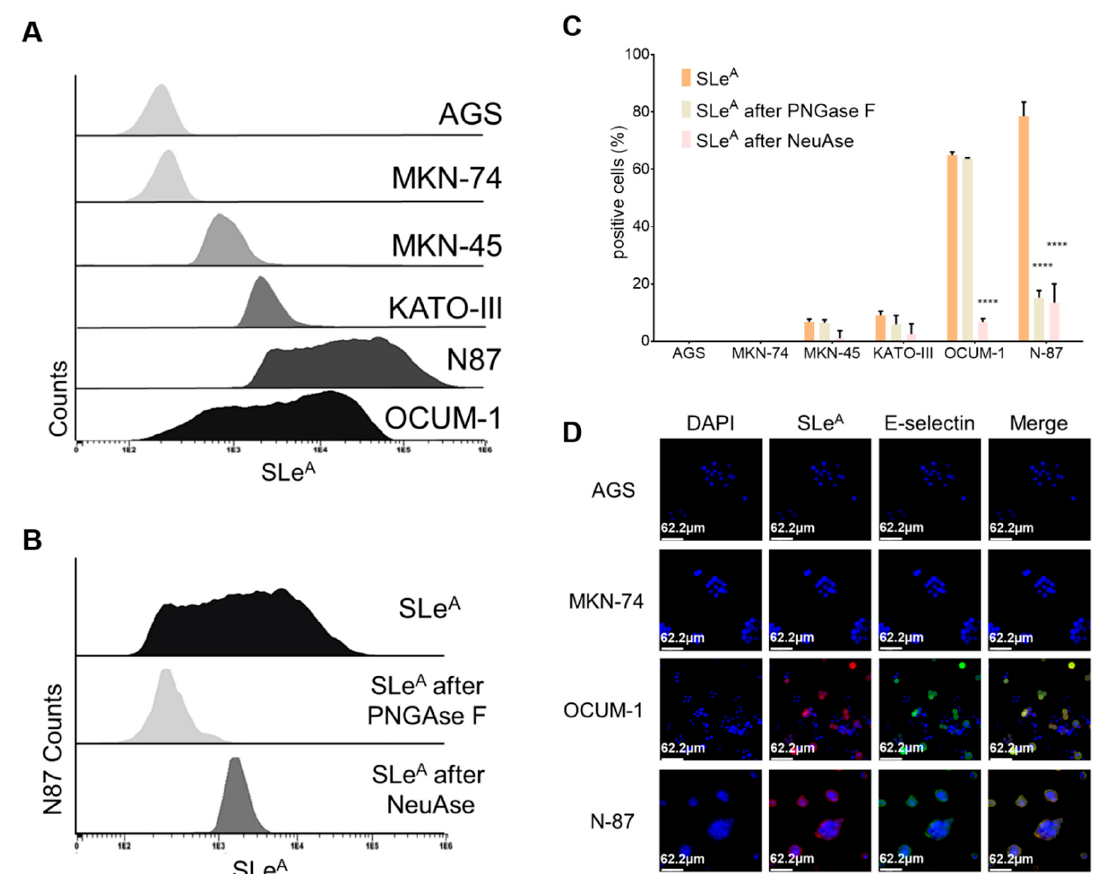
Figure 1. Expression of SLeA and a ffi nity to E-selectin of di ff erent GC cell models. ( A ) SLeA expression in di ff erent cell models (AGS, MKN-74, MKN-45, KATO-III, N87 and OCUM-1). The FACS histogram in panel A highlights the levels of SLeA in AGS, MKN-74, MKN-45, KATO-III, N87 and OCUM-1 cells, ranked from the lowest to highest expression. Notably, AGS and MKN-74 were negative for the antigen, whereas N87 and OCUM-1 presented the highest expression levels. ( B ) Evaluation of the origin of SLeA expression based on N-deglycosylation with PnGase F. The histogram in panel B corresponds to control experiments involving PNGase F (for N-deglycosylation) and neuraminidase (NeuAse, sialidase) for cell line N87. This confirmed the specificity of the anti-SLeA antibody for sialylated structures and that the SLeA signals arises mostly from N-glycans. However, a still significant subpopulation of cells conserved SLeA antigen expression, suggesting also the presence of O-glycans and / or glycolipids carrying this alteration. ( C ) Summary of SLeA expression levels before and after N-deglycosylation and neuraminidase digestion for the six cell lines. Panel C summarizes SLeA evaluation for each cell line resulting from flow cytometry experiments, in agreement with the observations in panel A. Exposure to PNGase F had little e ff ect on MKN-45, KATO-III and OCUM-1 cell lines, suggesting that the majority of the SLeA may arise from the O-glycosylation of proteins and glycolipids. In N87 the major source of SLeA expression appears to be N-glycans. Nevertheless, considerable amounts of SLeA remain, suggesting that SLeA is also carried by O-glycans. Moreover, these signals were significantly decreased when cells were treated with neuraminidase prior to analysis, reinforcing the specificity of antibody recognition. * p < 0.05; ** p < 0.01; *** p < 0.001; and **** p < 0.0001. (Student’s t -test for three independent replicates) ( D ) E-selectin a ffi nity for SLeA negative gastric cancer cells lines (AGS and MKN-74) and cells expressing high amounts of the antigen (OCUM-1 and N87) by fluorescence microscopy. The panel shows that E-selectin binding (green) is dependent on SLeA expression (red). Nuclei were counterstained with DAPI (blue).